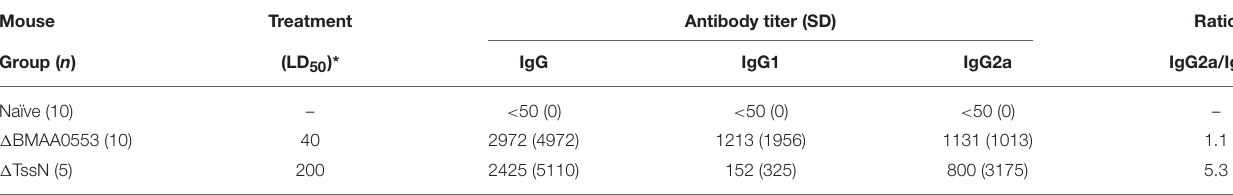
TABLE 1 | Antibody responses to 1 BMAA0553 and 1 TssN after aerosol exposure in BALB/c mice. Mouse